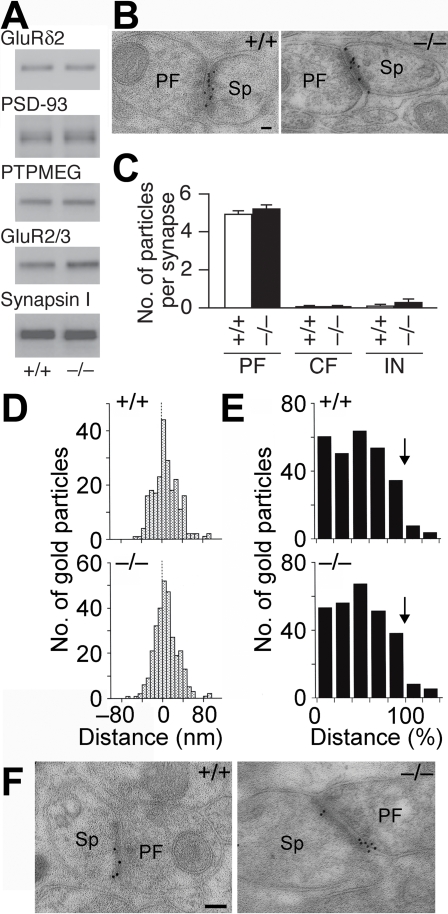
Expression and distribution of GluRδ2 at PF-PC synapses.A, Representative Western blots of GluRδ2, PSD-93, PTPMEG, GluR2/3 and Synapsin I in the cerebellum. B, Postembedding immunogold for GluRδ2 at PF-PC synapses. PF, parallel fiber; Sp, spine. C, The number of immunogold particles for GluRδ2 per profile of PF-PC synapses (+/+, n = 217; −/−, n = 179), CF-PC synapses (+/+, n = 12; −/−, n = 23) and IN-PC synapses (+/+, n = 9; −/−, n = 25). Data are expressed as mean±SEM. D, Perpendicular localization of GluRδ2 at PF-PC synapses. The distances from the midpoint of the postsynaptic membrane to the center of gold particles were grouped into 8-nm bins. E, Tangential localization of GluRδ2 at PF-PC synapses. The relative medio-lateral position of gold particles is indicated as the percentage of the distance from the center (0%) to the edge (100%) of the PSD. Arrows indicate the boundary of PSD. F, Postembedding immunogold for AMPA receptors at PF-PC synapses. PF, parallel fiber; Sp, spine. Scale bars: B,F, 100 nm.